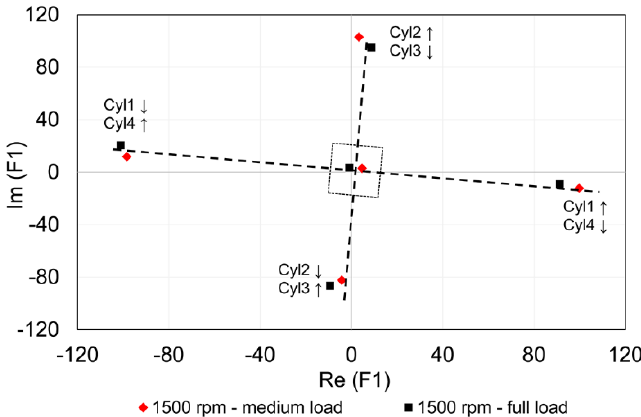
Figure 12. Representation in the complex plan of the F1 order at 1500 rpm and two loads in case of homogeneous injection and by varying the injected fuel in each cylinder of ± 5 mm 3 /cycle.